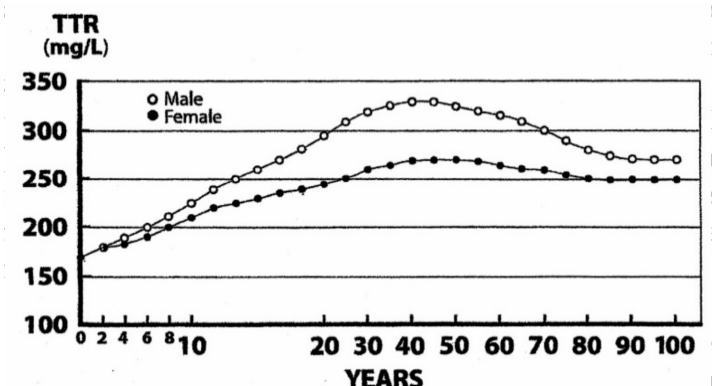
Figure 3. Evolutionary profiles of TTR concentrations throughout the human lifespan. TTR values were measured in the blood samples from 67,720 healthy U.S. citizens using immunoturbidimetric analysis (Bienvenu, 1996) [79]. Equipment and reagents were provided by Beckman-Coulter Inc., Brea, CA 92622, USA and measurements were performed using the skillful expertise of the Foundation for Blood Research, Scarborough, ME 04070, USA. TTR and LBM values manifest closely superimposable trajectories: the lowest values are measured at birth, there is linear increase without sexual di ff erence until the onset of puberty, and there is an occurrence of sexual dimorphism with more pronounced rise in adult males because of a larger muscular size, followed by plateau levels until the age of 65 years, and then a narrowing of the gap between both TTR curves, revealing the disappearance of the sexual di ff erence in the last decades. TTR and LBM curves show comparable abrupt S-shaped elevations at the onset of adolescence until the beginning of adulthood, which are partially obliterated due to alterations in the graduation of abscissa